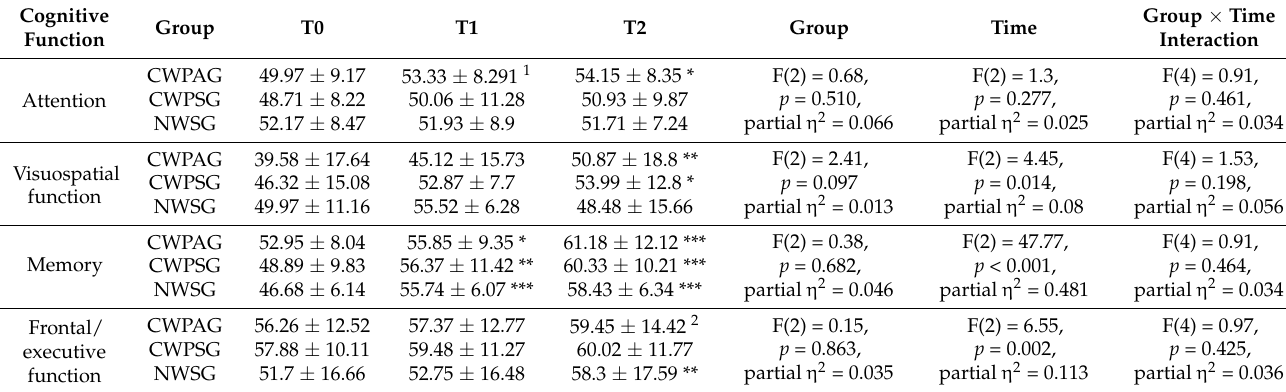
Table 2. Comparison of cognitive